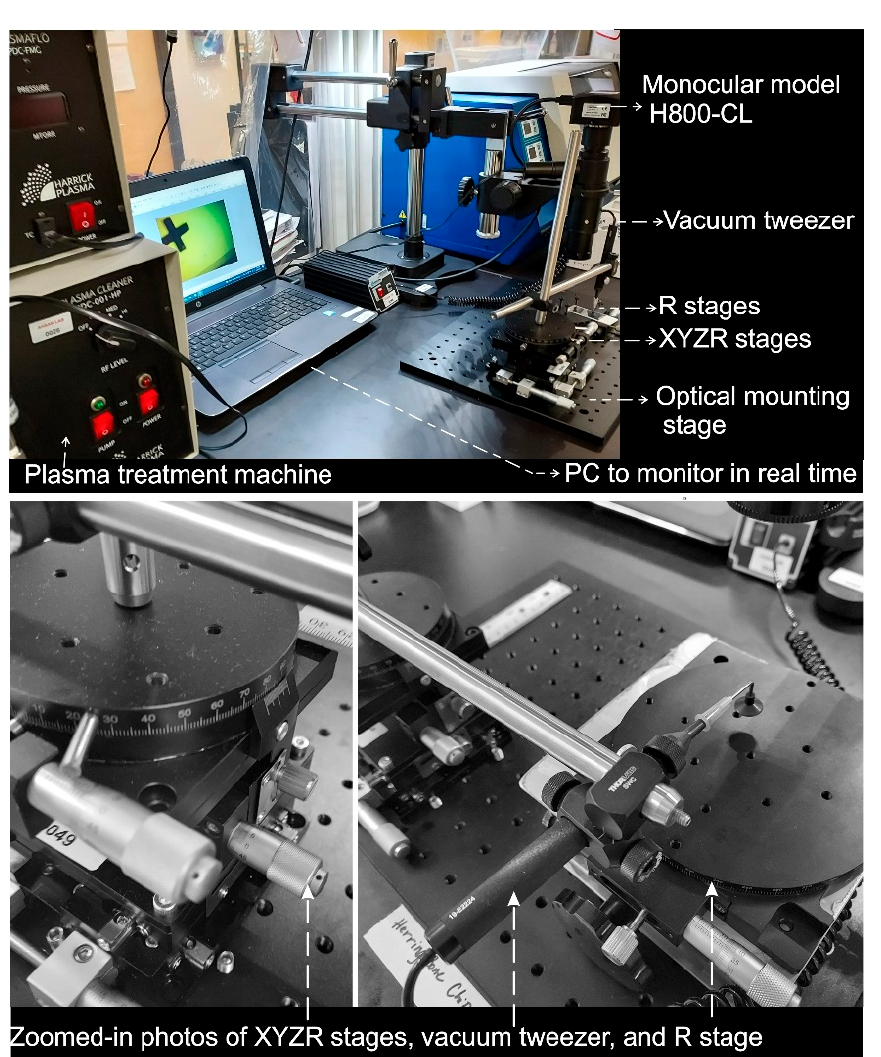
Figure 2. Digital picture of the alignment station for chips and wafer ‐ scale PDMS slabs aligner.